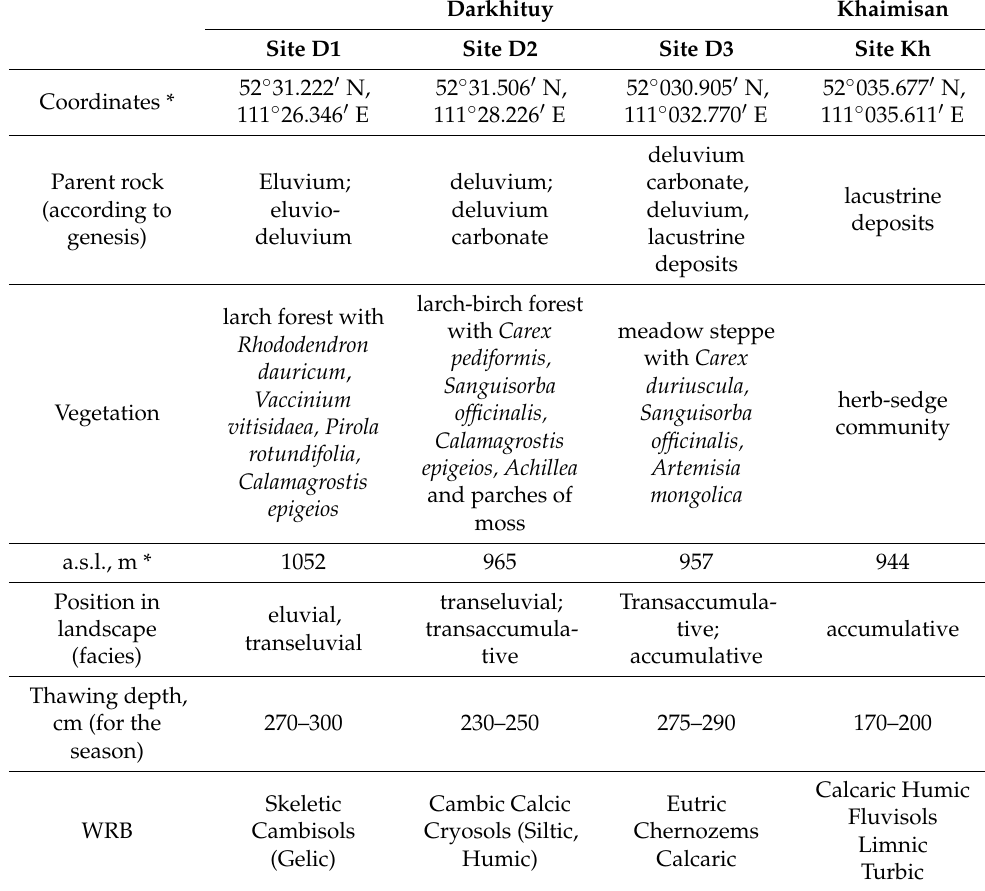
Figure 1. Map-scheme of the sampling sites along the Darkhituy–Khaimisan transect on the Vitim Plateau (Buryatia, Russia). At the right part of the map, the scale is 1:500,000. Table 1. Characteristics of sampling sites by [3,14].